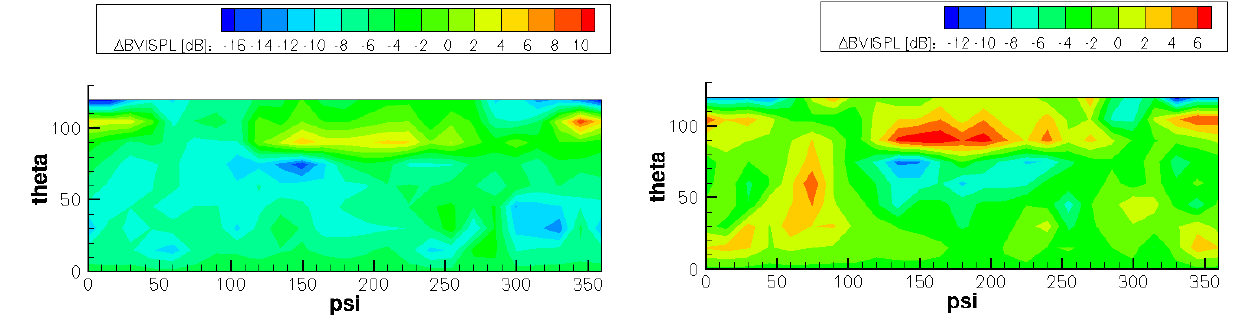
Figure 14: Technique A – C differential BVISPL at point 2 in maneu- ver